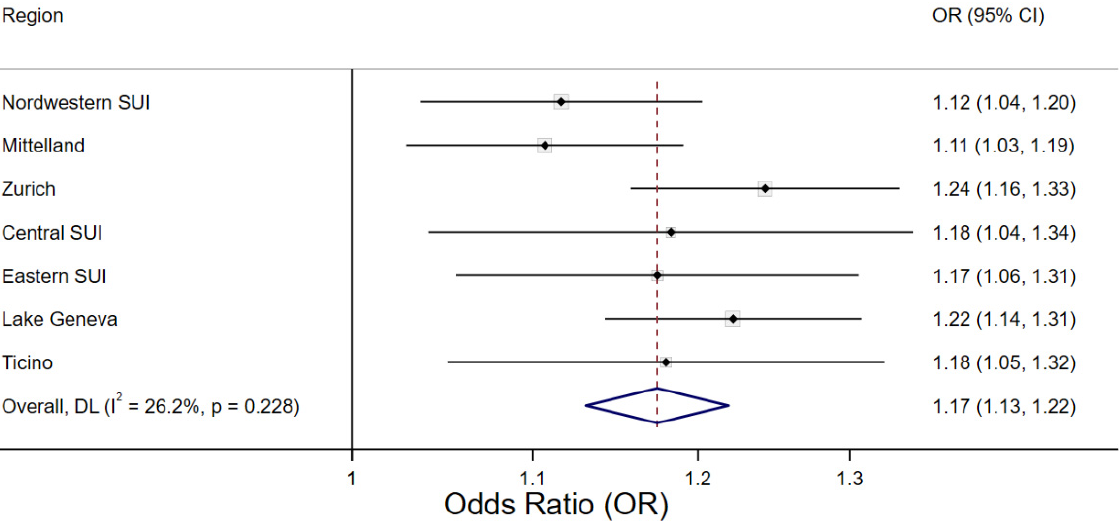
Figure 4. Forest plot of region-specific Odds Ratios (ORs) of mortality associated with Tmean exceeding 25 °C. The threshold of 25 °C corresponds to the 98th percentile of the daily mean temperature (Tmean) distribution during the warm season in Switzerland between 2003 and 2016.